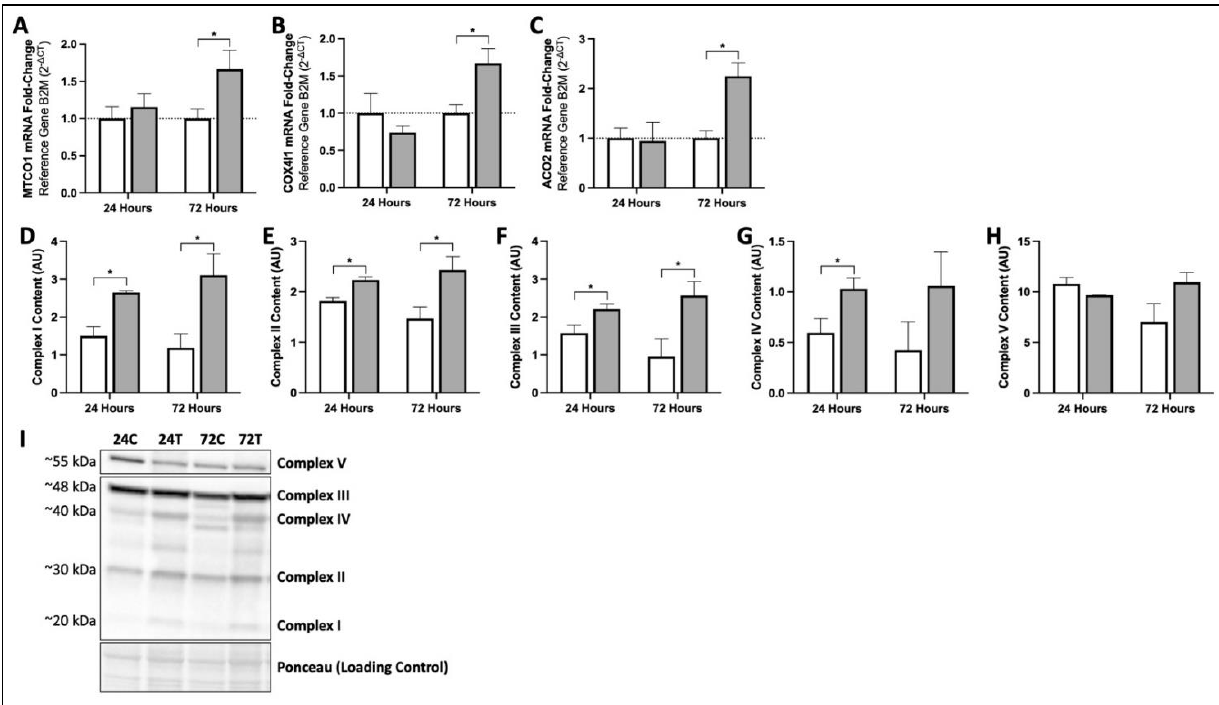
Figure 2. MIS elevates production of key mRNA species and proteins responsible for mitochondrial function and oxidative phosphorylation in human fibroblasts. MIS supplementation results in sig- nificantly greater amounts of mRNA compared to CON for: ( A ) MTCO1 , ( B ) COX4I1 , and ( C ) ACO2 in human fibroblasts. ( D – F ) Both 24 and 72 h of MIS supplementation results in greater Complex I, II, and III protein content than CON, while ( G ) a greater Complex IV content is significant following 24 h of supplementation. ( H ) Complex V protein content remains unchanged as a result of treatment. ( I ) Representative Western blot images depict protein content for Complexes I to V. White bars in- dicate CON treatment, grey bars indicate MIS treatment. n = 3 independent donor biopsies per group. Data are mean ± SEM. * indicates p < 0.05 via unpaired t -test.